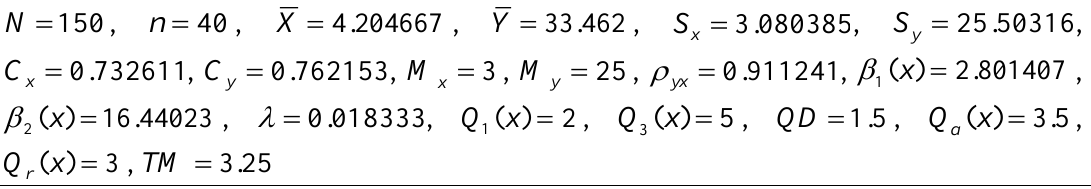
Table 4. Parameters of the population